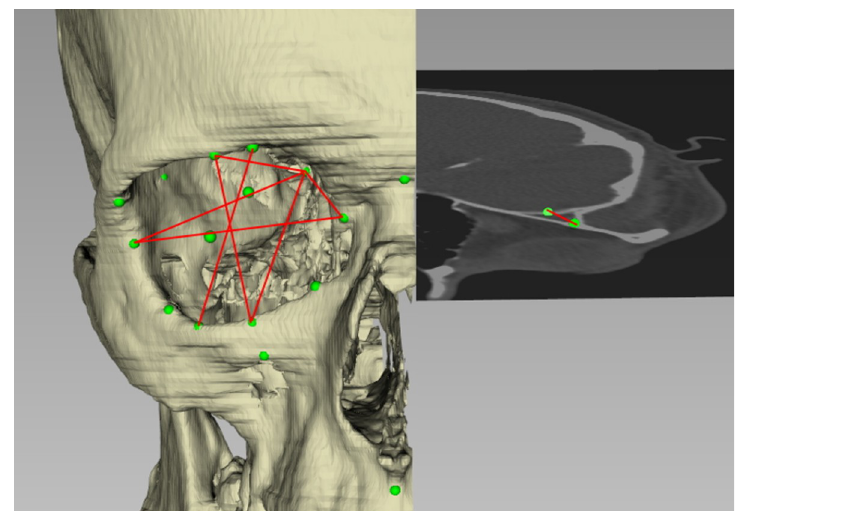
Fig 2. Visualization of distances shown in Table 2.